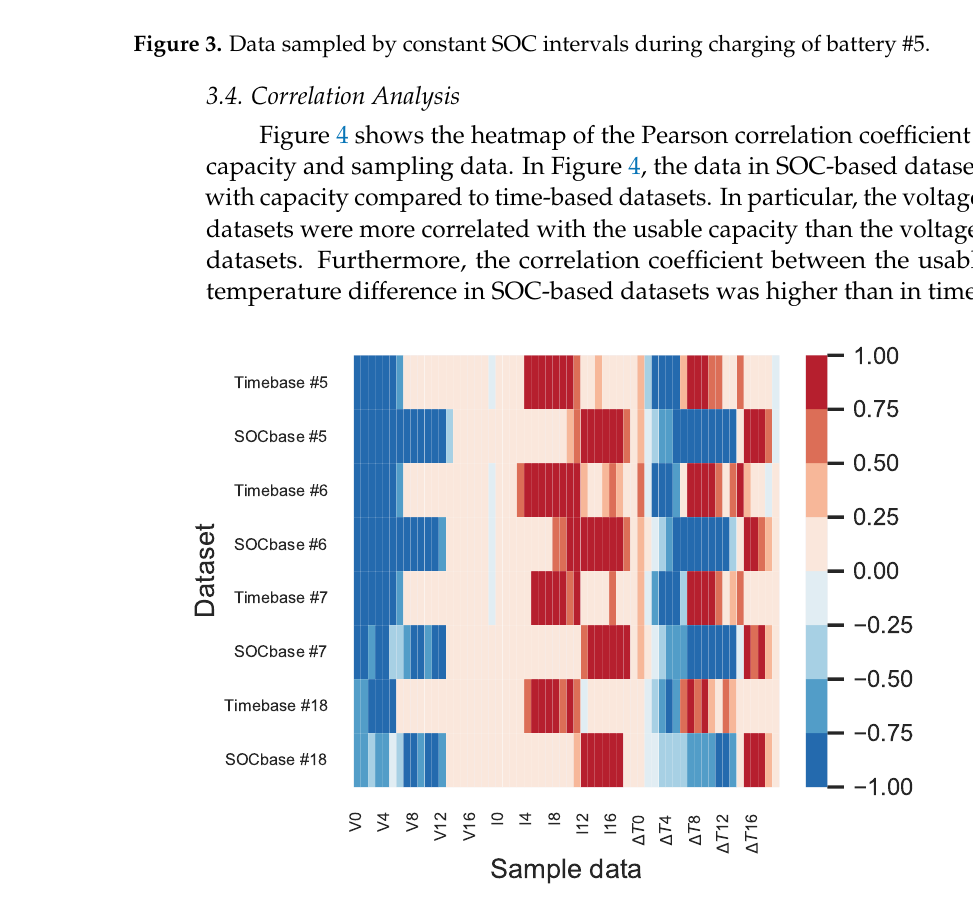
Figure 4. Heatmap of the Pearson correlation coefficient for the data processing method between the usable capacity of the battery and the sample data of current, voltage, and temperature difference during